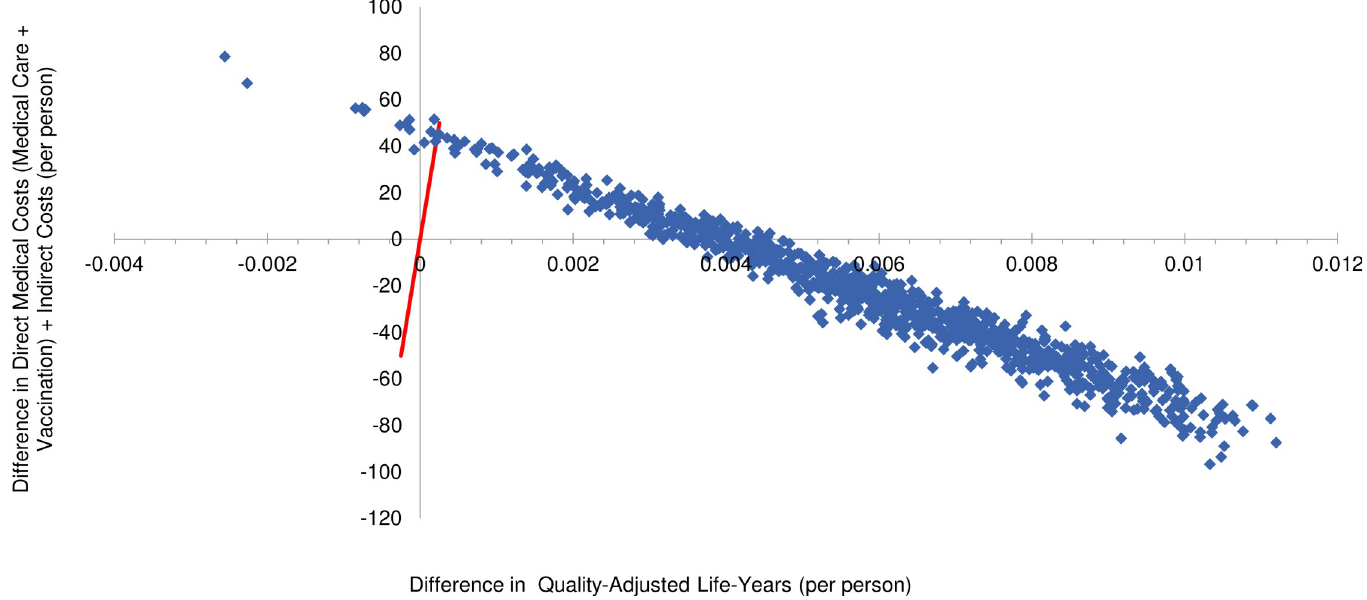
Fig 11. Graphical illustration of PSA for the private health care sector HIV-infected model. Costs are indicated in 2015 South African rand.